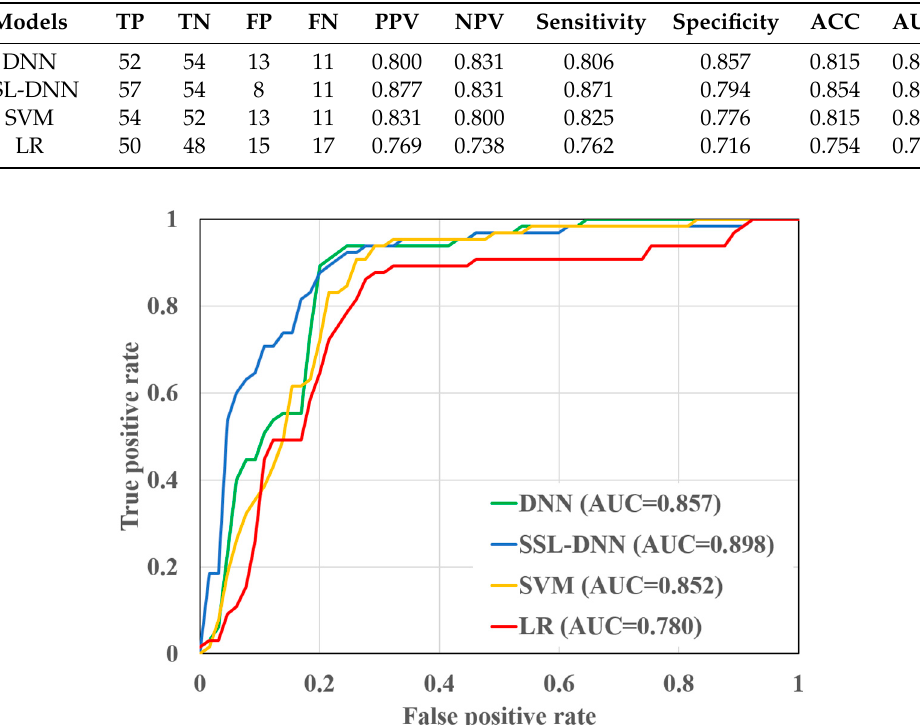
Figure 12. ROC curves of the predictive rate.